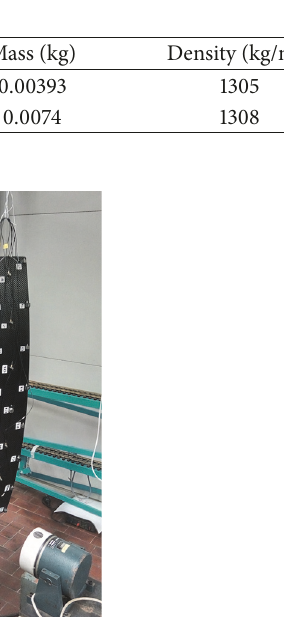
Figure 4: The leaf spring component: the experimental configura- tion with 23 accelerometers.